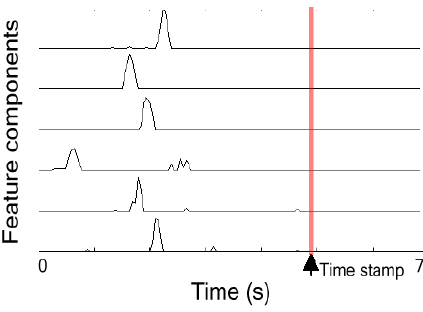
Fig. 4. Feature sparse components of the neuronal activity in rat PFC during the working memory task.